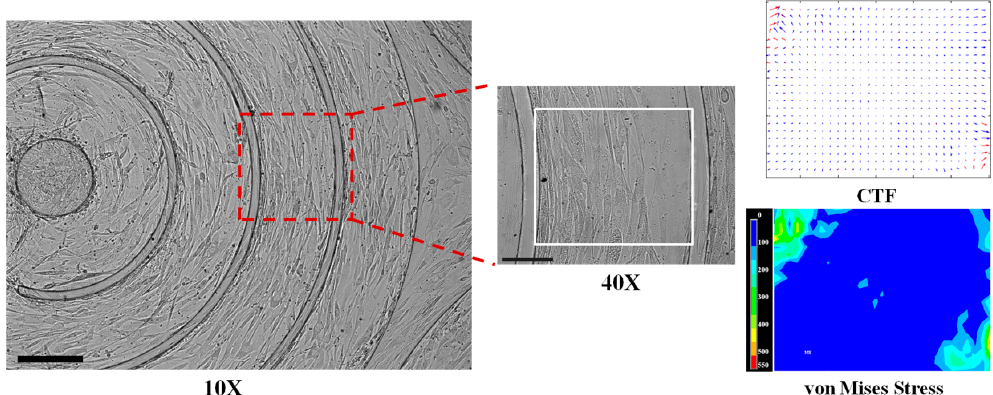
Figure 4. The distributions of CTFs and von Mises stresses of a confluent SMC sheet aligned in the circumferential direction. Scale bars are 250 µ m and 100 µ m in the 10X and 40X images, respectively.